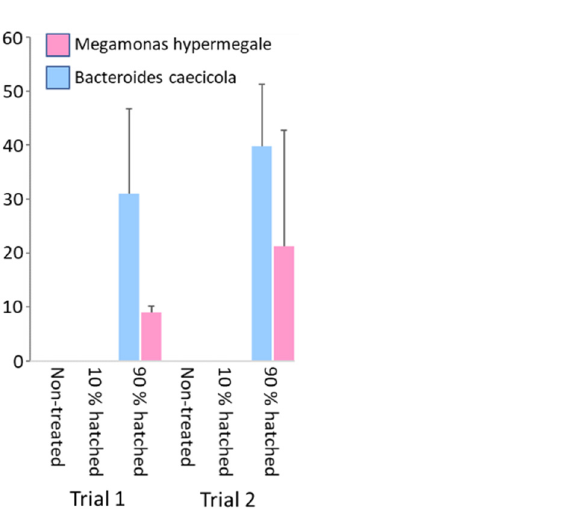
Figure 4. Influence of conventional and sterile feed on caecal microbiota composition and body weight of chickens. ( A ), Composition of caecal microbiota in the chickens was affected by conventional or sterile feed. Asterisks indicate OTUs differently abundant in microbiota of chickens fed conventional or sterile feed. ( B ), Feed microbiota consisted of chloroplast 16S rRNA (different shades of green in conventional feed) and the only viable bacterial species in the feed was Bacillus licheniformis . Feed, therefore, was not the main source of gut microbiota for chickens. Autoclaving resulted in degradation of plant chloroplast DNA and negatively affected nutritional quality, which influenced microbiota composition ( A ) but also chicken body weight ( C ). *—significantly different in microbiota of chickens provided with conventional or sterile feed by Mann–Whitney test. #—significantly different by t -test.